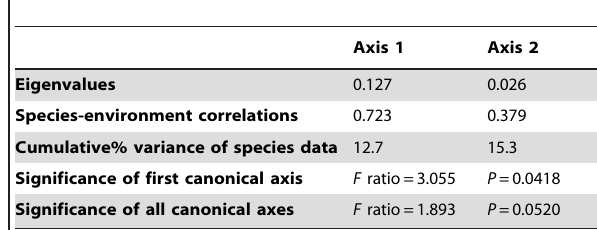
Table 4. Eigenvalues, species-environment correlations, cumulative percentage variance in species data explained, and significance of first and all canonical axes in the best redundancy analysis RDA (2.5km scale) for the pollinator species